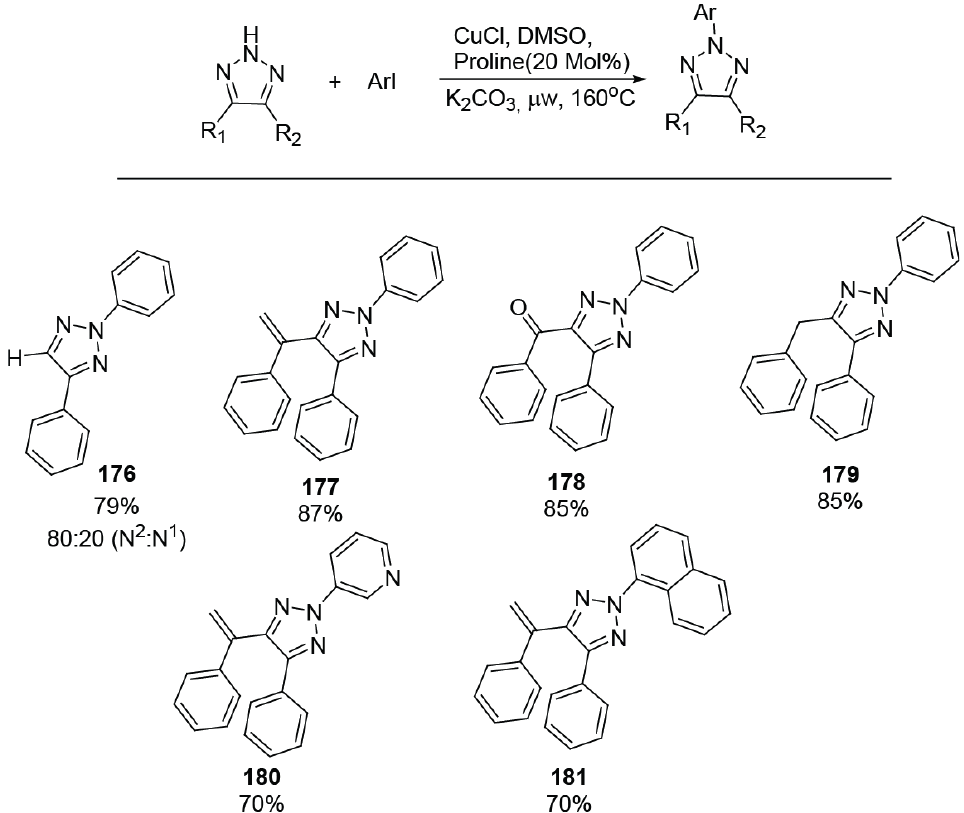
Figure 24 - The copper catalyzed N 2 Arylation of substituted